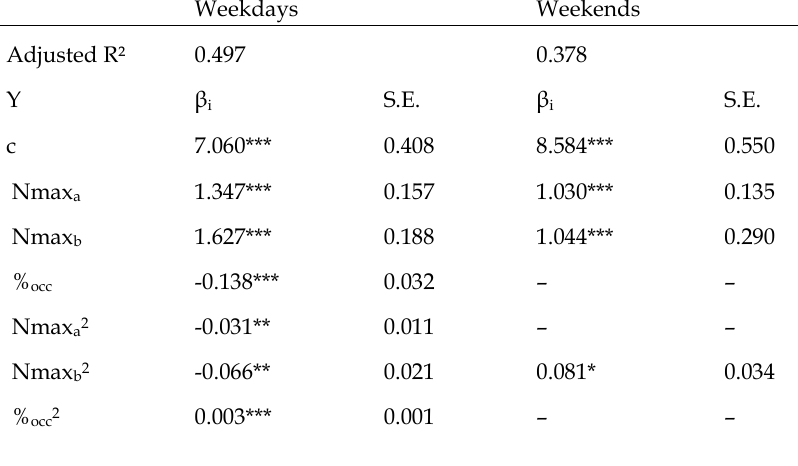
Table 4. Regression model parameters (weekdays and